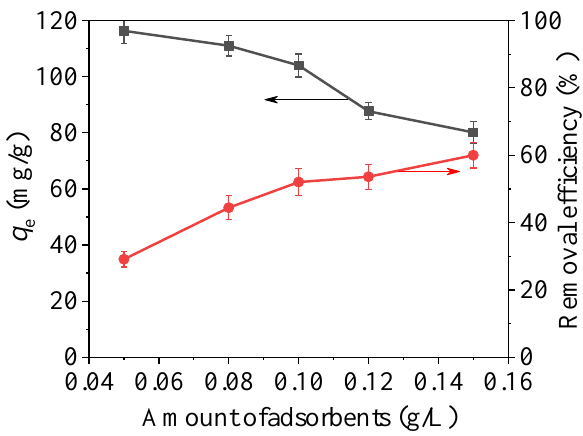
Figure 11. Effects of dosage with CoFe 2 O 4 @SiO 2 -EDTA as adsorbent (pH = 7, C 0 = 20 mg/L, t = 6 h, T = 298 K).